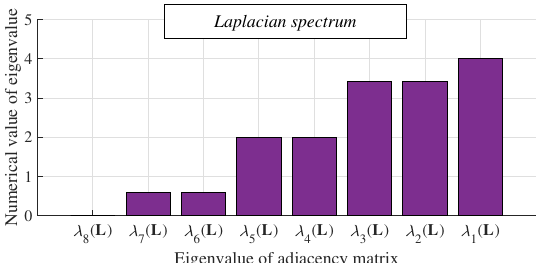
Figure 10. Laplacian spectrum of bipartite regular connected graph formed by eight vertices and with maximum degree equal to two − example.